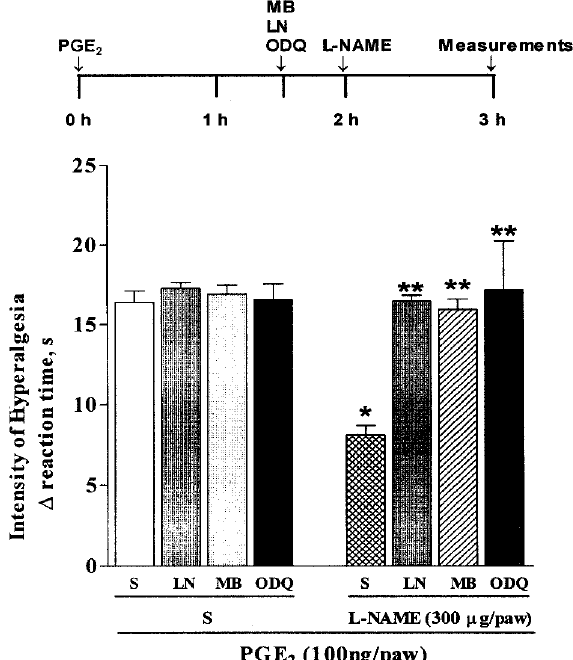
FIG. 3. Blockade by L-NMMA (LN) and guanylate cyclase inhibitors (MB and ODQ) of the antinociceptive effect of L-NAME on PGE 2 induced hyperalgesia. PGE 2 was injected at time zero, saline (S) or LN, MB,ODQ, at time 1.5h and L-NAME or S 2h after PGE 2 . The insert shows the anti- nociceptive effect of L-NAME (60 = a, 180 = b and 300 m g per paw = c).The bars and symbols are the mean ± SEM of five rats/group. The asterisks mean significant differences ( P < 0.05): (a) *in comparison with the control PGE 2 ; (b) **in comparison with L-NAME-treated